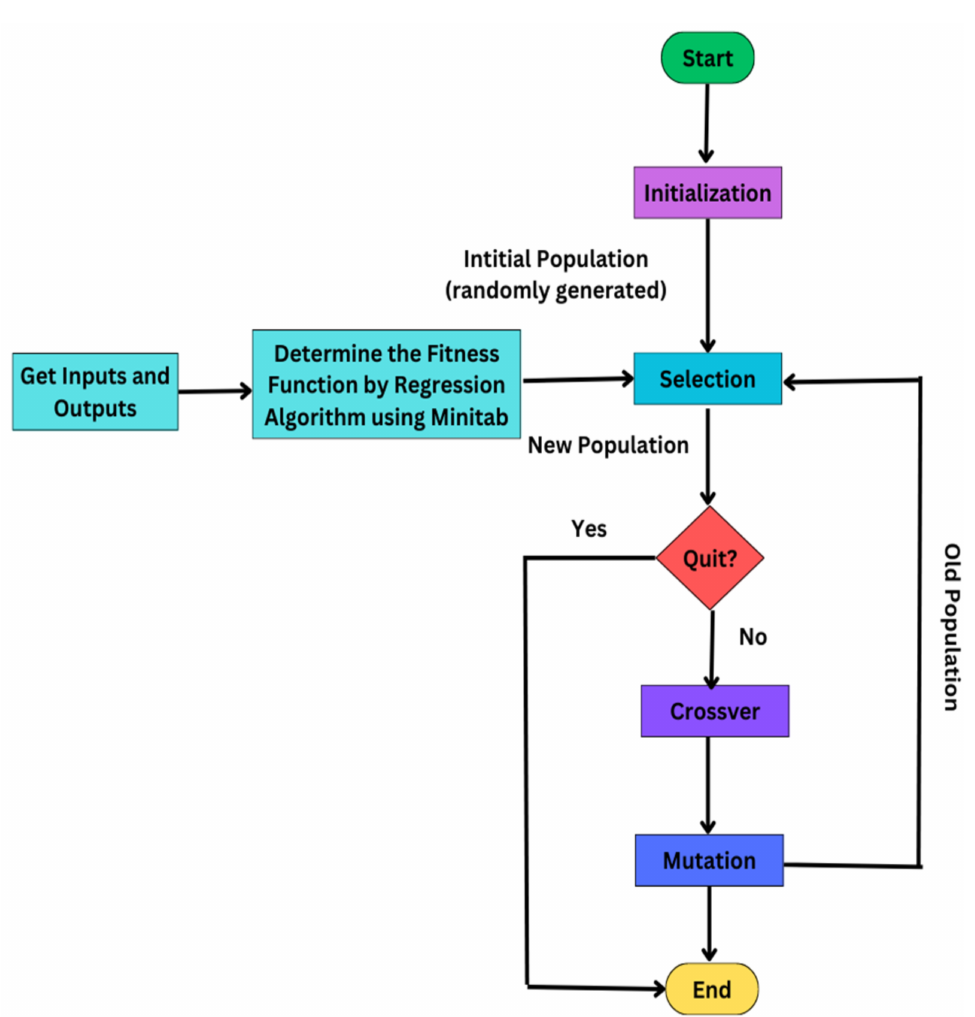
Figure 3. Fundamental flowchart of